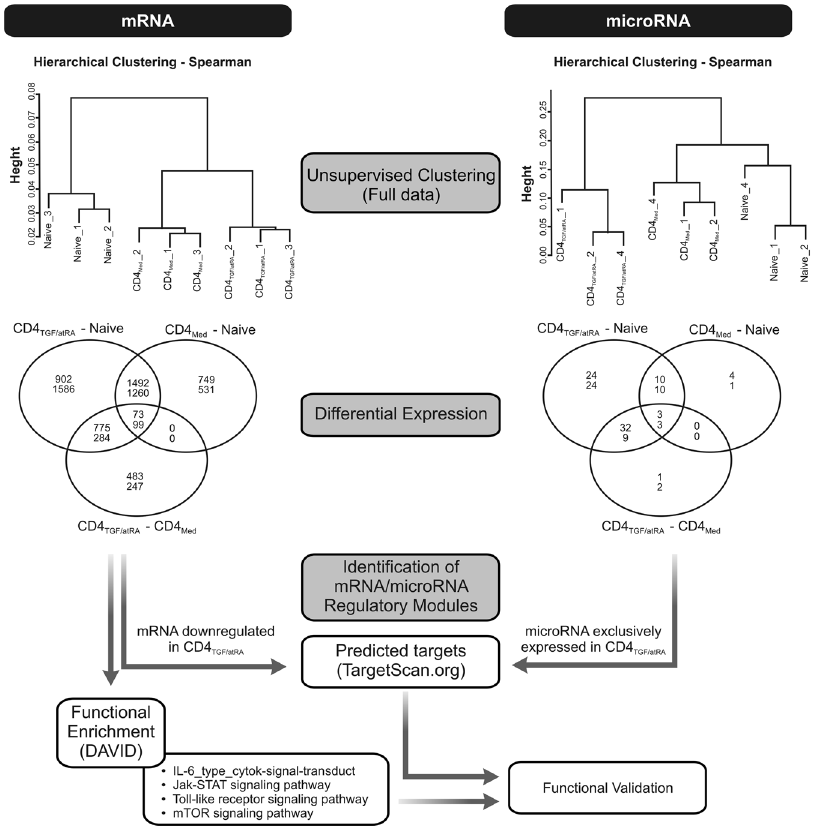
Figure 4. Bioinformatic analysis strategy. In order to identify potential microRNA/mRNA regulatory mechanisms acting during the generation of iTregs, we evaluated the microRNA and mRNA expression profiles of freshly isolated UCB naïve T-cells and of activated cells cultured in CD4 Med and CD4 TGF/atRA conditions. Unsupervised clustering analysis of full transcriptional profiles was carried and differentially expressed transcripts were determined and Venn-Diagrams were used to depict similarities and differences. A group of downregulated transcripts predicted by TargetScan to be targeted by miRs exclusively detected in CD4 TGF/atRA were submitted to an enrichment analysis using DAVID, allowing the identification and selection of downmodulated signaling pathways for functional